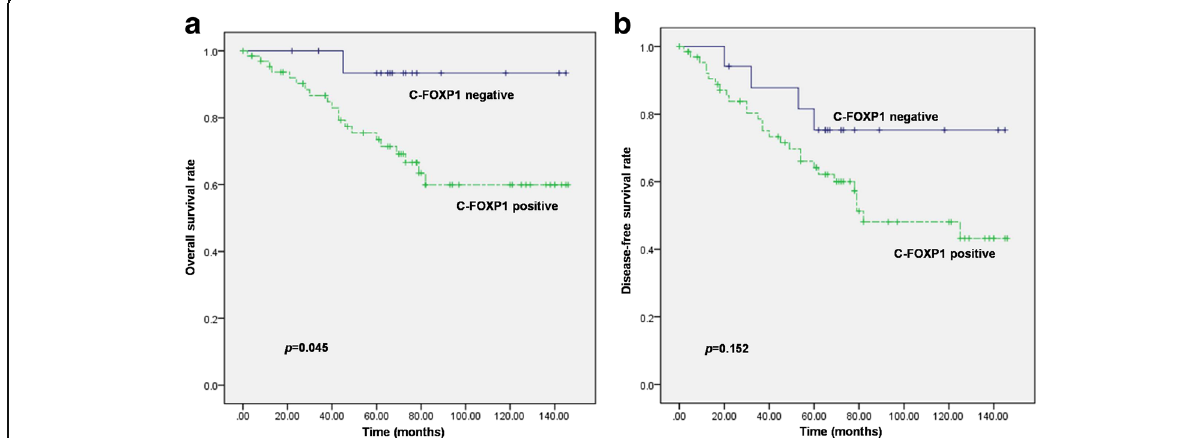
Fig. 5 Kaplan-Meier survival curves of patients with IDC according to C-FOXP1 expression. Patients with positive C-FOXP1 immunoreactivity showed inferior OS ( a ) and DFS ( b ) compared with C-FOXP1-negative patients, although the difference in DFS was not statistically